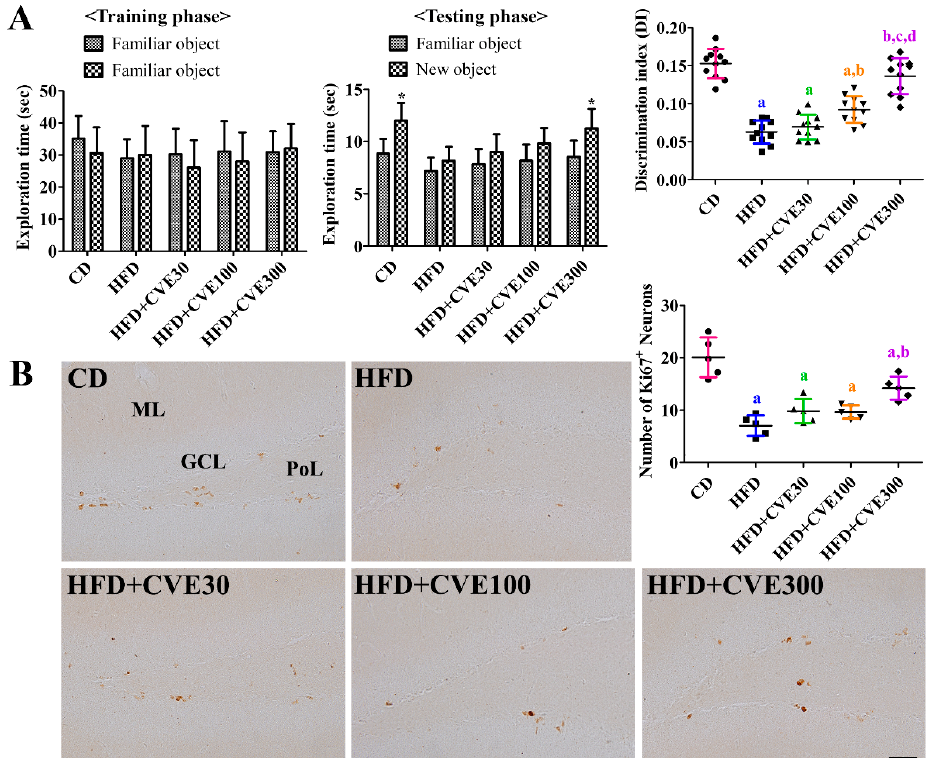
Figure 4. Exploration time for familiar and familiar or new (novel) objects during training and testing phase as well as calculated discrimination index in the testing phase ( A ) as well as immunohistochemical staining for Ki67 ( B ) in the CD, HFD, HFD+CVE30, HFD+CVE100, and HFD+CVE300 groups at 8 weeks after treatment. The number of Ki67-immunoreactive neurons was counted in the dentate gyrus per section. The data were analyzed by two-way analysis of variance for exploration time and one-way analysis of variance followed by Bonferroni’s post hoc test for others (* p < 0.05, significantly different from the familiar object; a p < 0.05, significantly different from the CD group; b p < 0.05, significantly different from the HFD group; c p < 0.05, significantly different from the HFD+CVE30 group; d p < 0.05, significantly different from the HFD+CVE100 group). The bars indicate